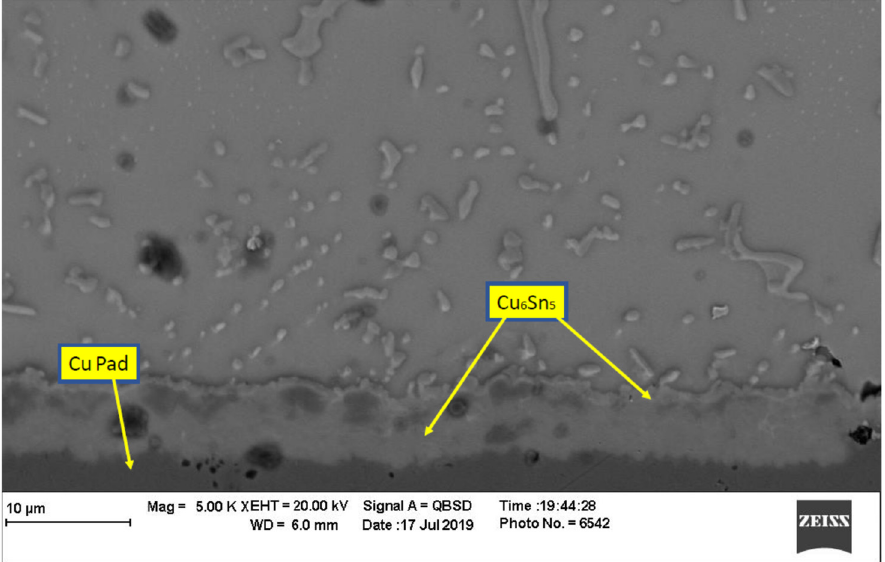
Figure 10. Microstructure of the junction zone between Cyclomax and the copper pad of a sample that underwent heat aging for 1000 h.